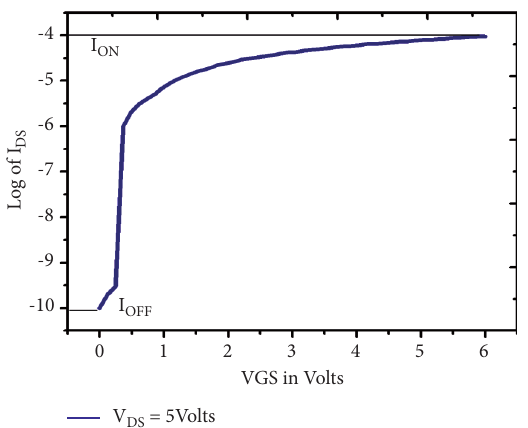
Figure 13: Transfer characteristics of V of Si-MOSFET (log. of drain current vs. V GS 2 O 5 thin film gate dielectric